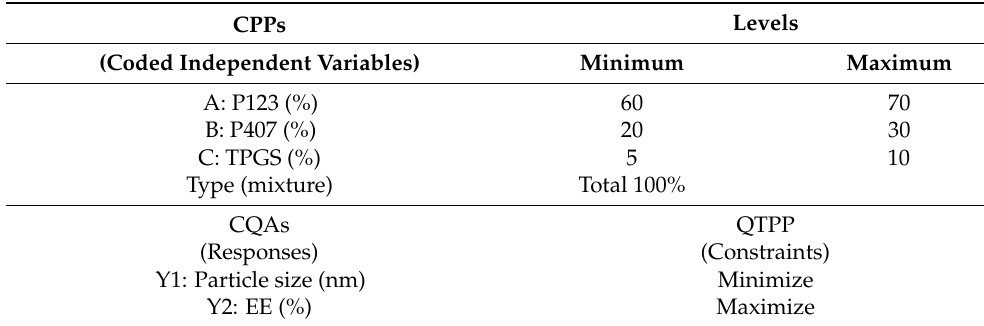
Table 5. Critical process parameter levels, critical quality attributes and quality target product profile for OZ polymeric micelles were produced utilizing the D-Optimal design. CPPs